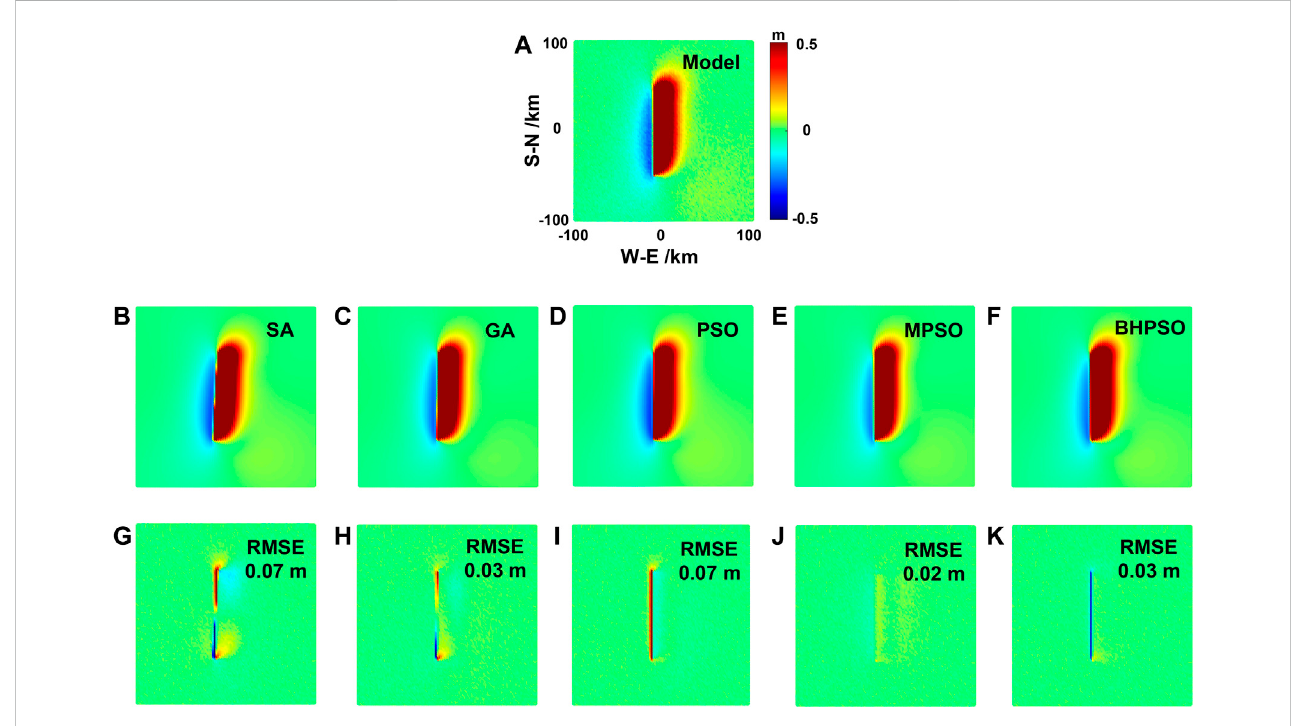
FIGURE 6 The comparisons of surface horizontal deformation (InSAR data) of the Okada model results from the oblique-slip fault earthquake by using fault parameters given by the model and inversed from fi ve methods in Table 3. The surface horizontal deformation obtained by model (A) , SA method (B) , GA method (C) , PSO method (D) ,MPSO method (E) , andBHPSO method (F) . The residual ofsurfacehorizontaldeformation between the results ofmodel and SA method (G) , model and GAmethod (H) , model and PSO method (I) , model and MPSO method (J) , model and BHPSO method (K) . The bluearrowsshow the simulated surface horizontal deformation by the model in Table 3. The red arrows show the simulated surface horizontal deformation by using the fault parameters inversed from the fi ve methods. The black arrows show the fi tting residuals. The positive value in color bar is the deformation away from the satellite, while the negative value is the deformation close to the satellite.